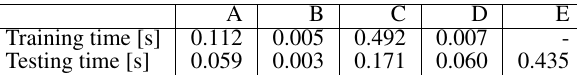
Figure 14. Anomaly detection maps of the MLM and reference methods for the artificial dataset. A: MLM (cosine, variance, training set size 2500, R size 250), B: One-Class-SVM, C: